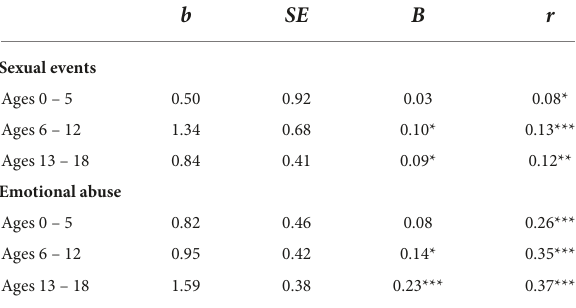
TABLE 4 Linear regression coefficients predicting loneliness from reported childhood experiences of sexual events and emotional abuse at different age ranges in Study